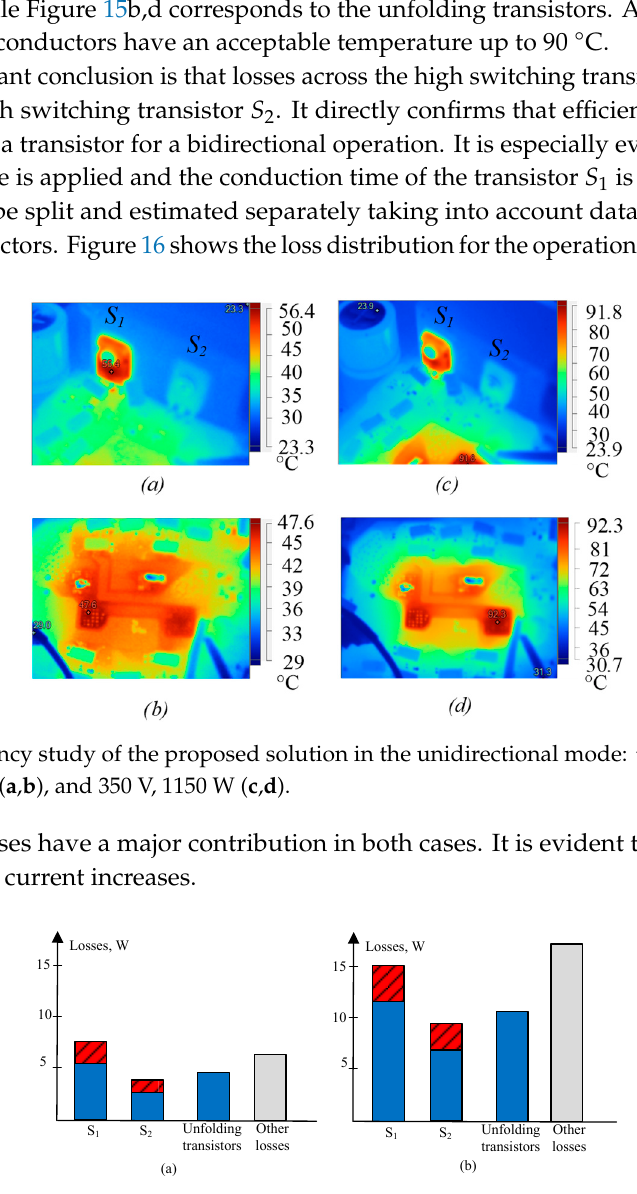
Figure 16. Losses distribution for 550 W at 250 V input voltage ( a ) and 1150 W at 350 V ( b ) input voltage.